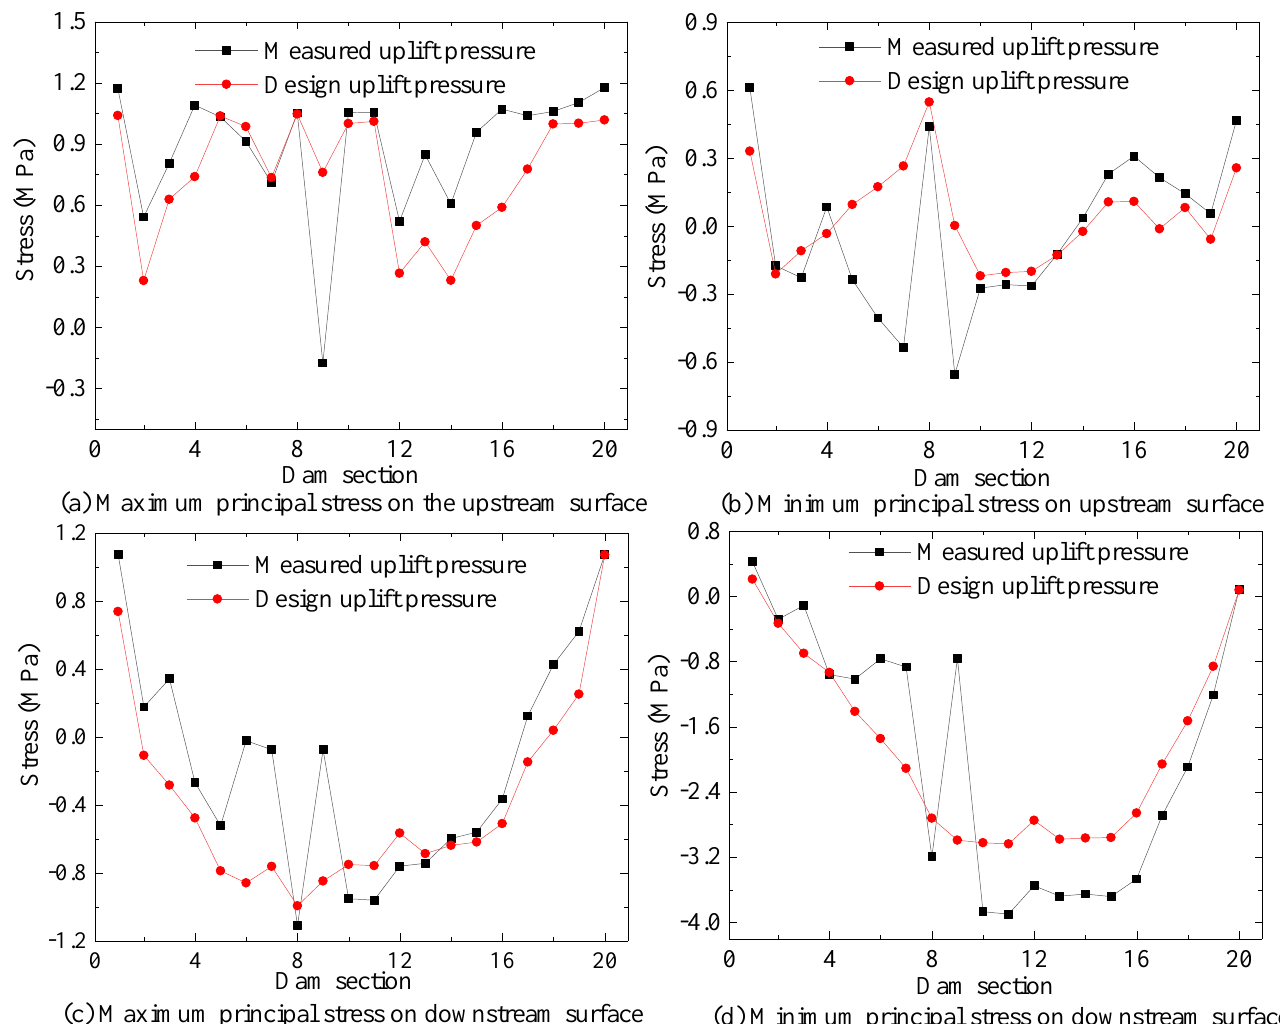
Figure 14. Comparison of equivalent stress of dam foundation under design and measured uplift pressure.